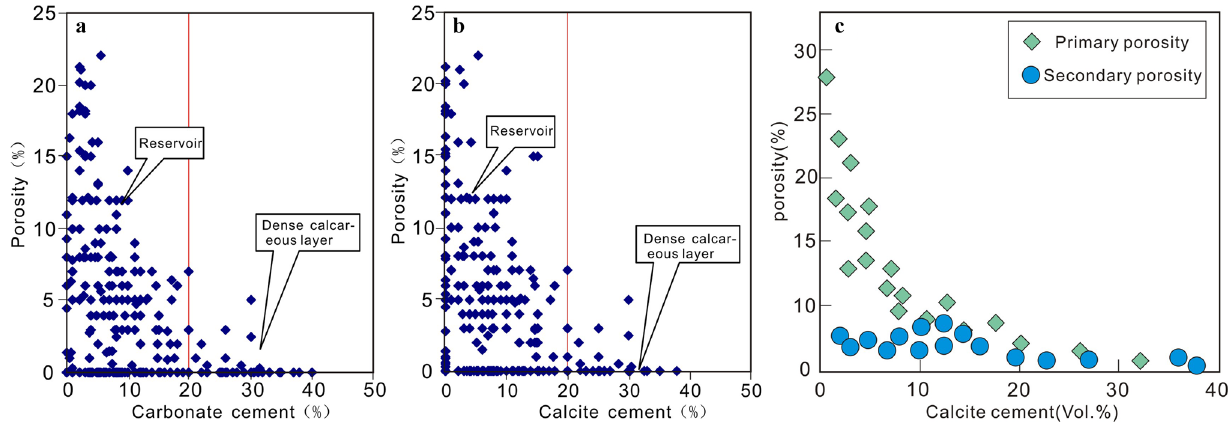
Fig. 10 a Cross plots of porosity and carbonate cement. b Cross plots of porosity and calcite cement. c Cross plots of primary and second- ary porosity and calcite cement; primary porosity is indicated by green rhombus, and secondary porosity is indicated by blue